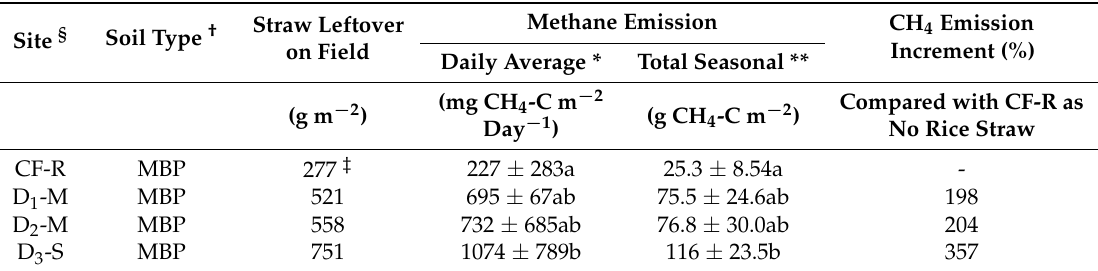
Table 4. Daily average ( ± , Standard deviation) fluxes and total seasonal ( ± , Standard deviation) CH 4 emission from paddy fields during growing season.